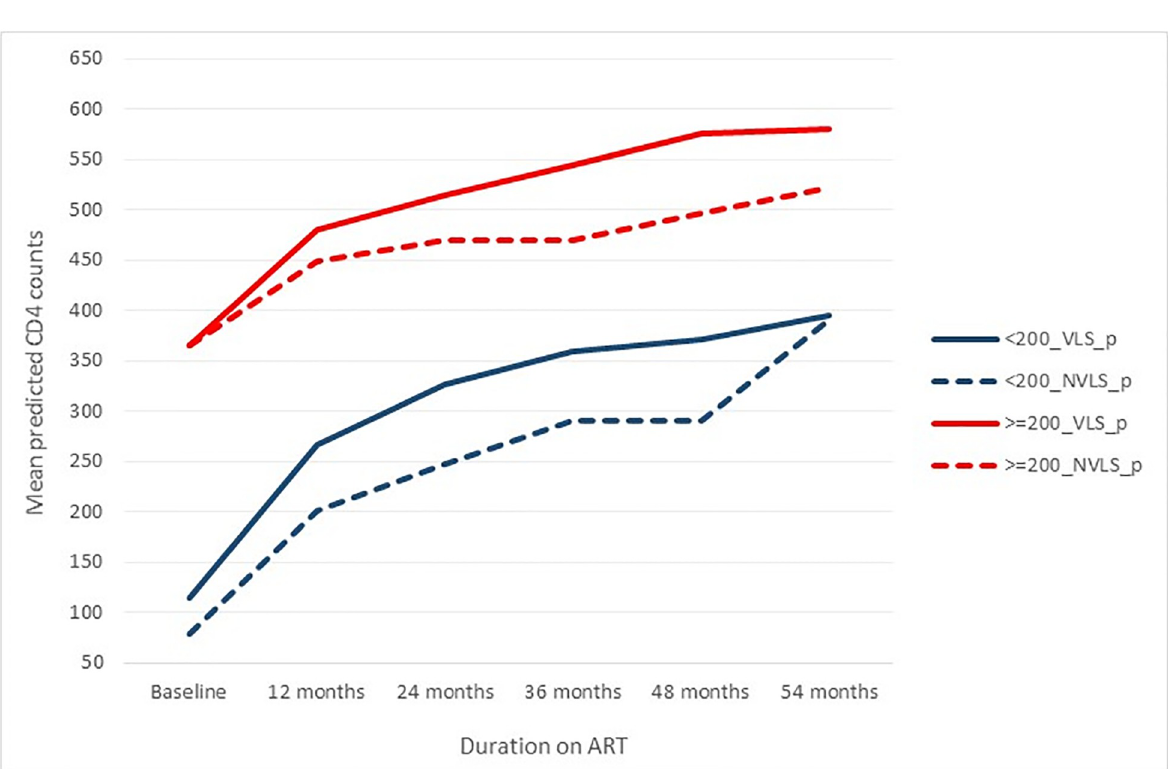
Fig 3. Predicted CD4 counts among those with or without viral suppression during follow up. https://doi.org/10.1371/journal.pone.0217742.g003 PLOS ONE | https://doi.org/10.1371/journal.pone.0217742 May 31,